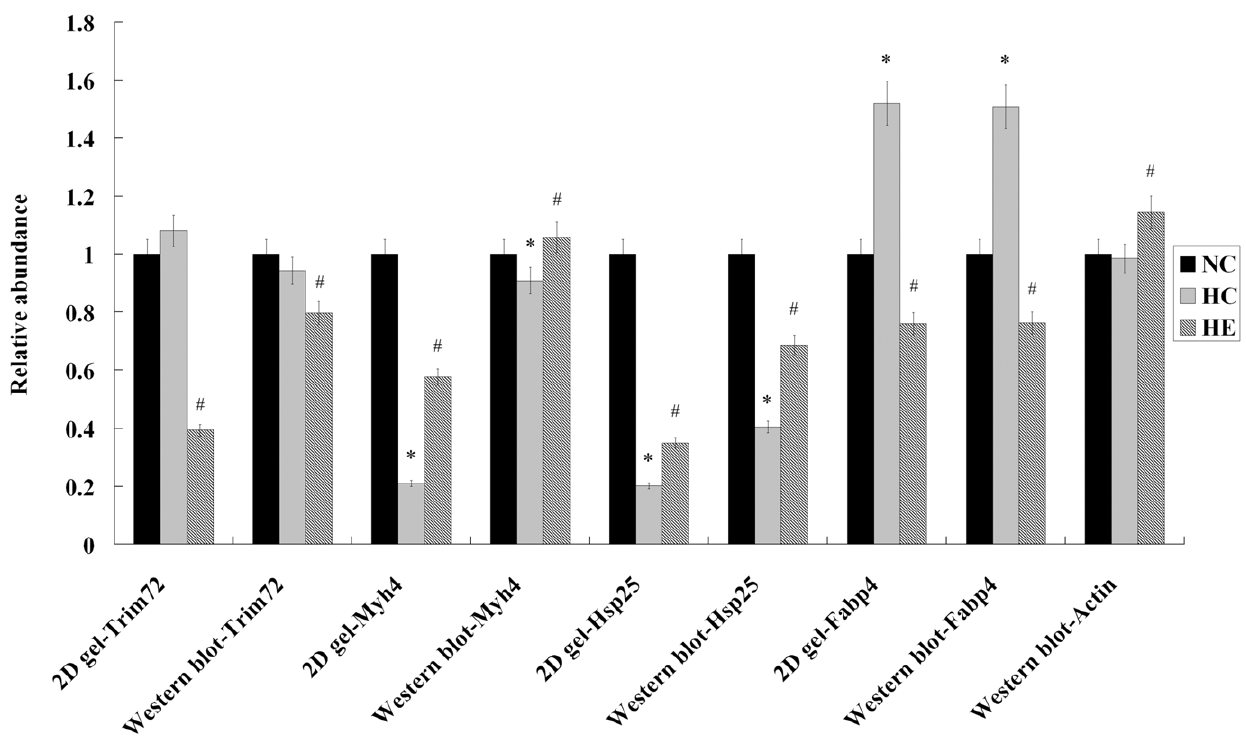
Figure 6. Relative abundance of the 2D gels and immunoblots. Results are means 6 SEM (n=6, each group). *: p , 0.05 HFD control (HC) vs. normal chow (NC); # : p , 0.05 HFD exercise (HE) vs. HFD control (HC).